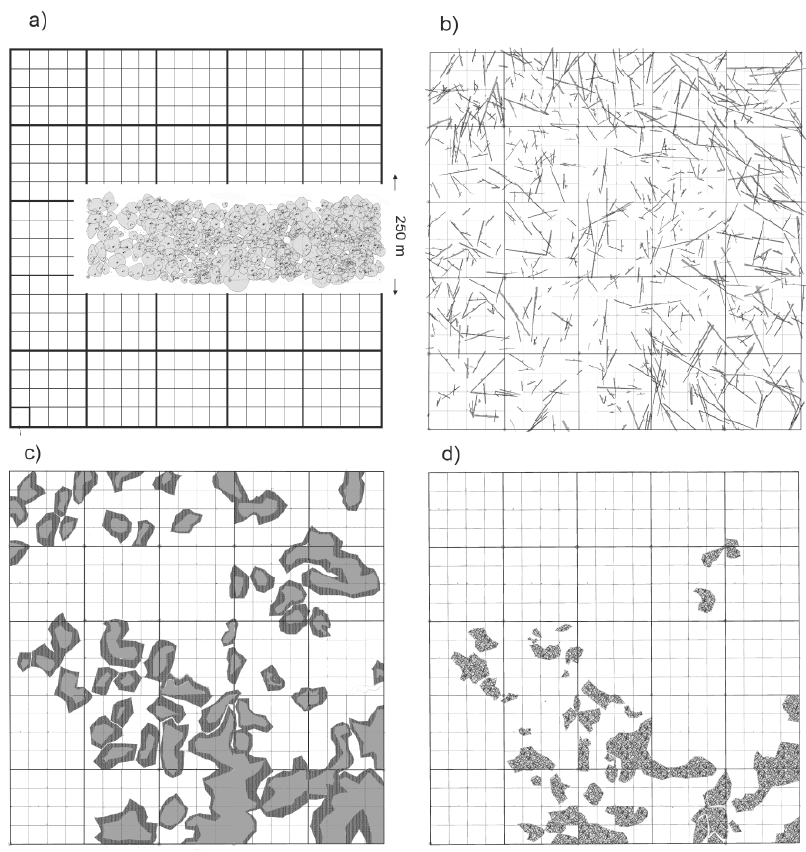
Figure 2. Output from the Field Map ® software package: ( a ) map of exact tree positions and their crown projections (only in transect), ( b ) map of downed deadwood (logs), ( c ) map of canopy openings (light grey: canopy gaps; dark grey: expanded gaps), ( d ) map of regeneration cover.